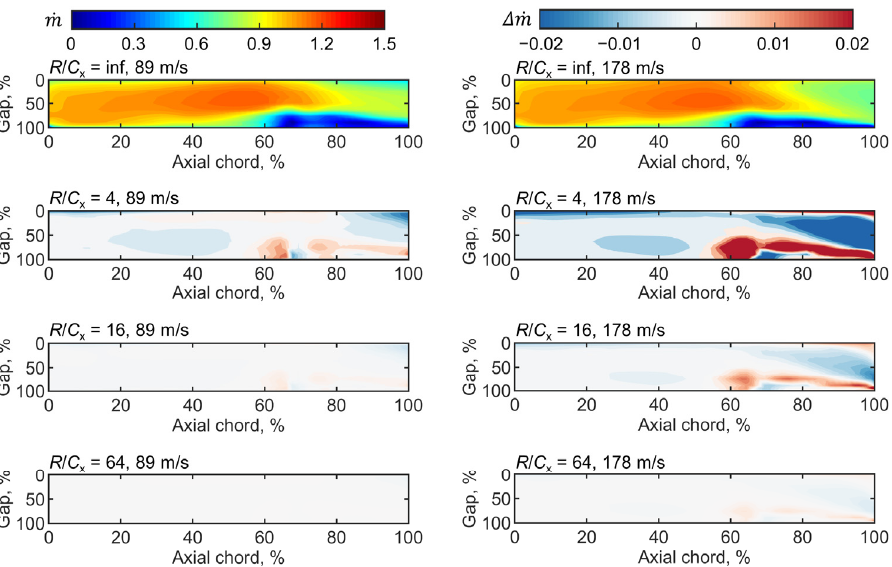
Figure 11. Density flow and its difference at various disk radii.